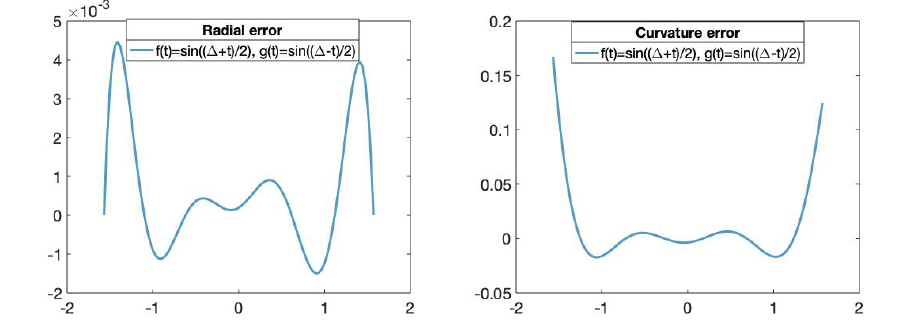
Figure 8. ( Left ): The x -axis represents the parameters t in [ − ∆ , ∆ ] and the y -axis represents the radial error value of the fitting curve obtained using the trigonometric basis. ( Right ): The x -axis represents the parameters t in [ − ∆ , ∆ ] and the y -axis represents the curvature error value of the fitting curves obtained using the trigonometric basis.